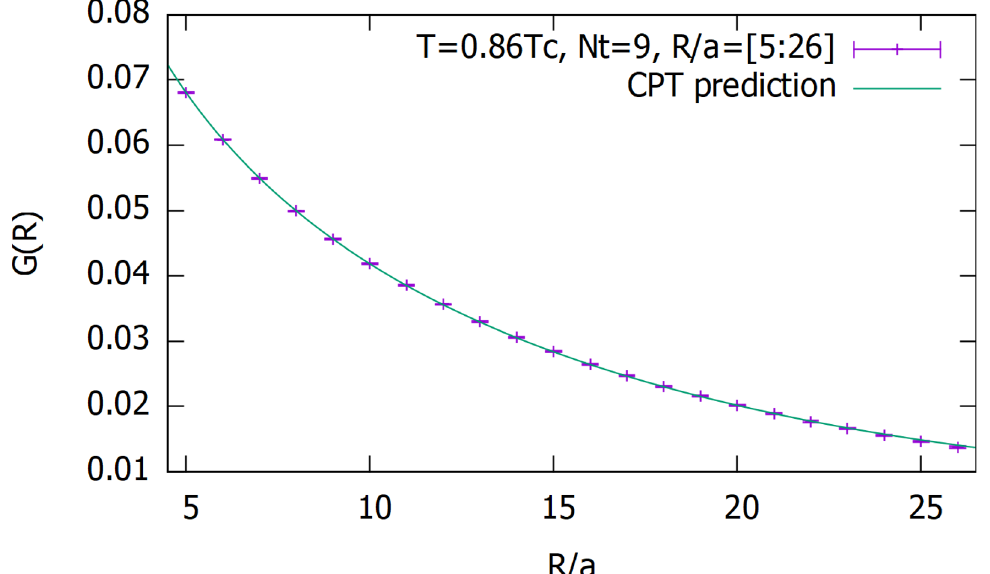
= 0 . 86 according c